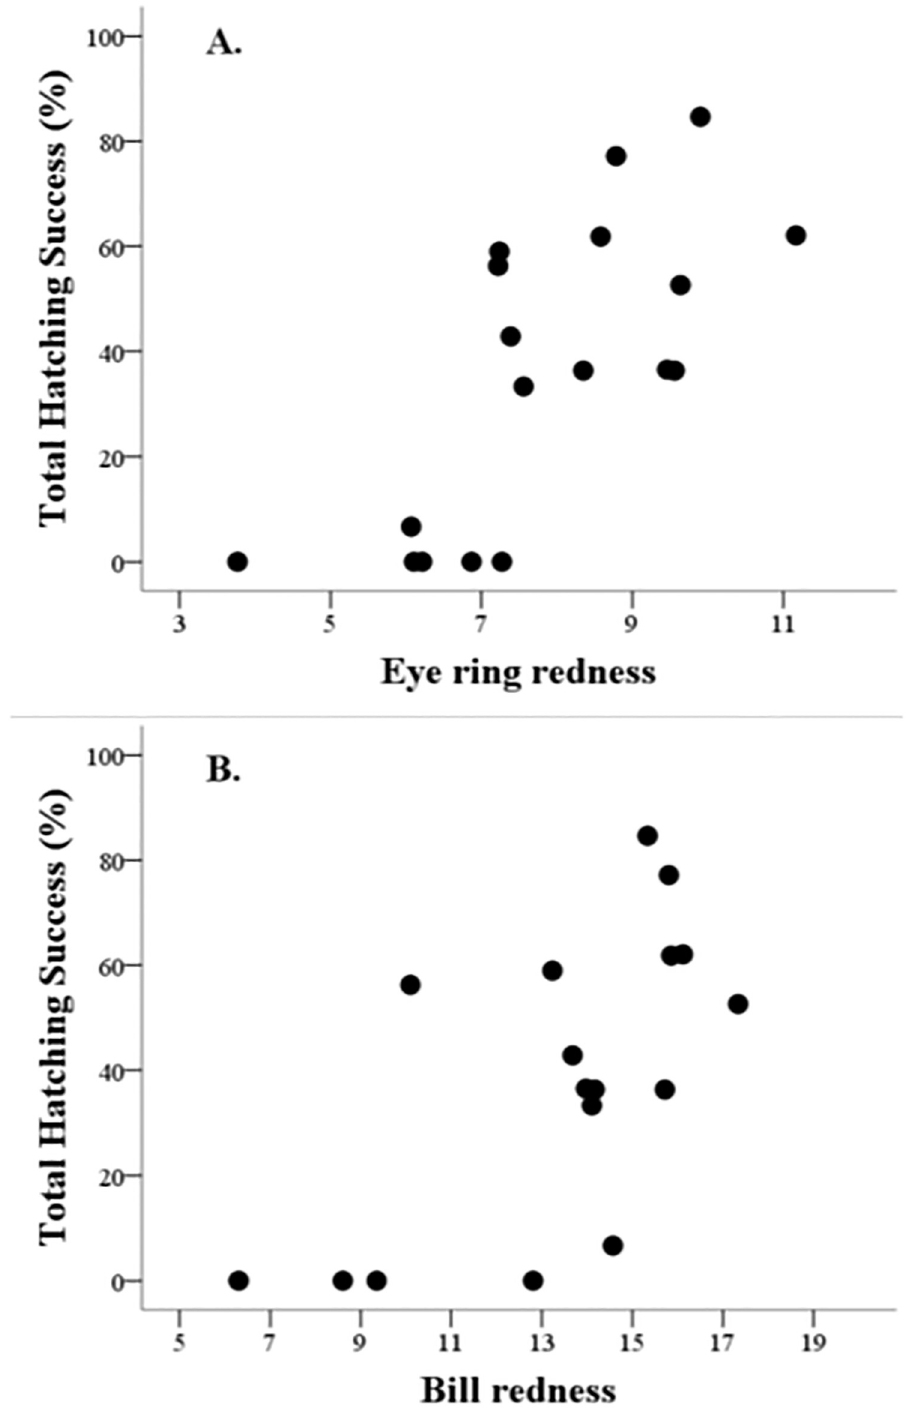
Fig 2. Relationship between total hatching success and eye ring (A) or bill (B) redness among control males. The total hatching success during lifetime was predicted by the redness of the eye ring (A) or bill (B) at the start of the first breeding season among control